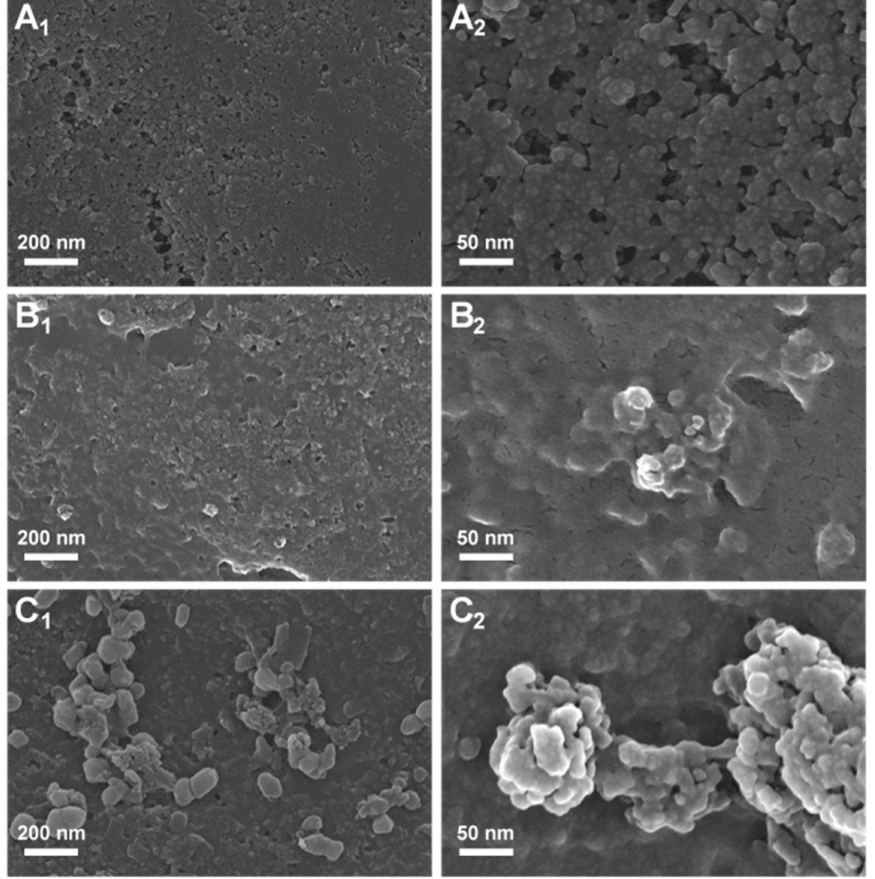
Figure 5. SEM images at ( 1 ) 50,000 and ( 2 ) 200,000 magnification: ( A ) electrode surface; the dsDNA biosensor ( B ) before and ( C ) after incubation in 500 µ M